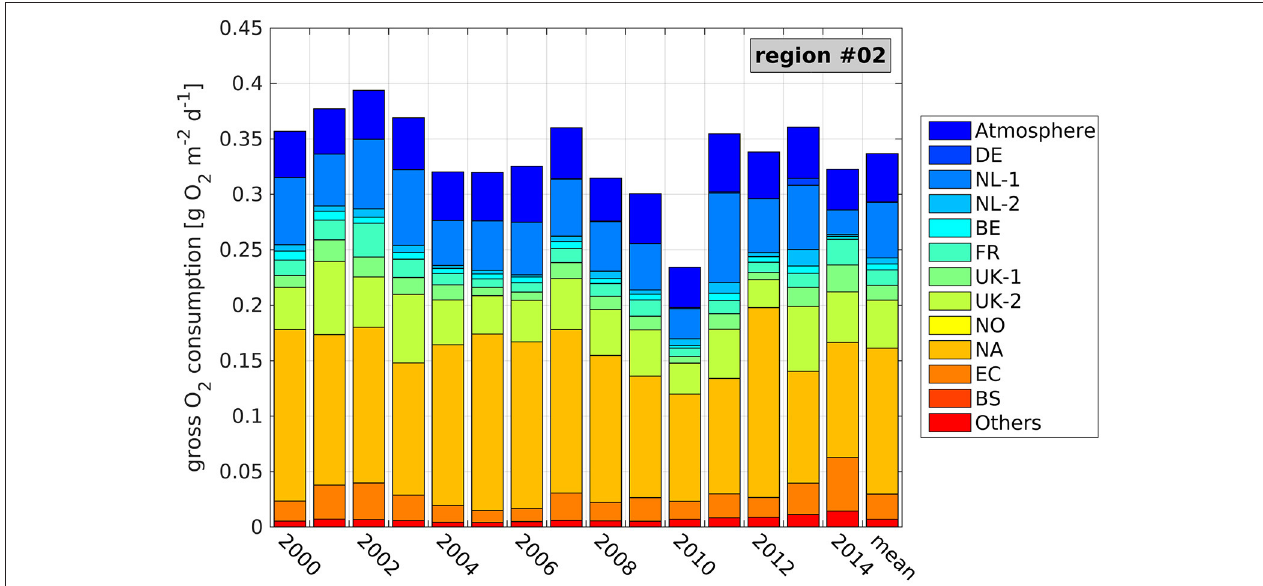
FIGURE 8 | Average daily, near-bottom gross O 2 consumption (GOC) during seasonal stratification and contributions of the different N sources (see Table 1 ) at the Oyster Grounds site (see Figure 5 , region 2) during the individual years 2000–2014, and averaged over the entire period. Values refer to a bottom layer thickness of 5.5m. Note different y axis compared to Figure 7